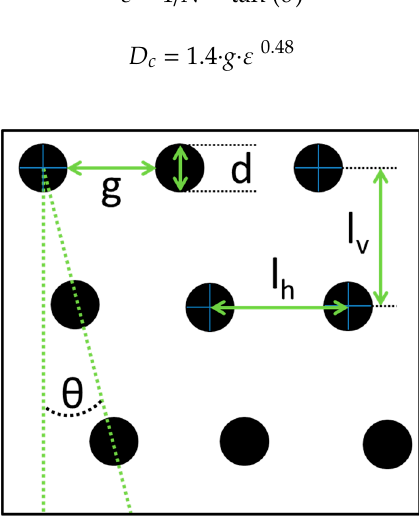
Figure 1. Illustration of the design parameters for a deterministic lateral displacement (DLD) array, with gap between posts ( g ), diameter of posts ( d ), row shift angle ( θ ) defining the period and the row shift fraction, as well as the horizontal and vertical center-to-center distance ( I h and I v ).